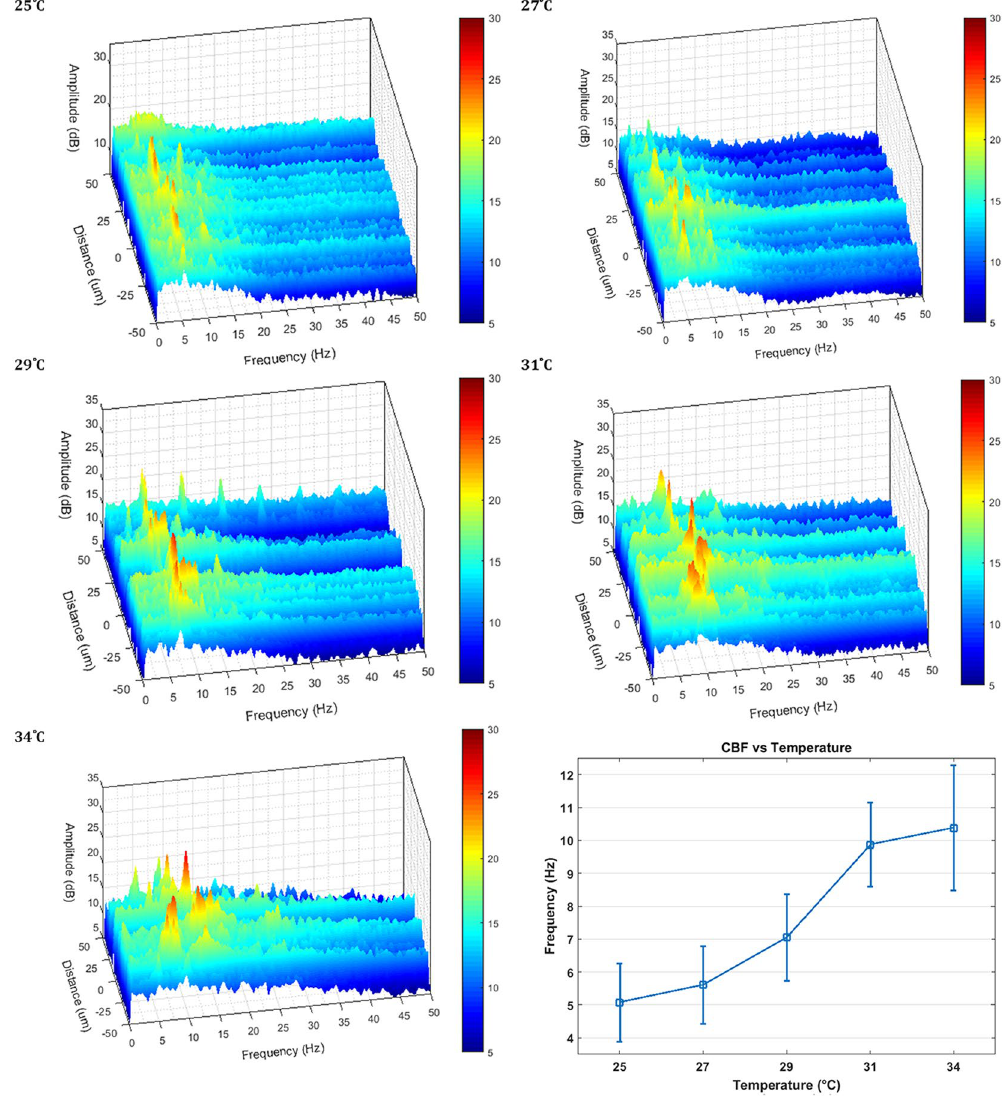
Figure 5. Power spectral density graphs showing peak CBF as a function of space across the sample at temperatures of 25 °C, 27 °C, 29 °C, 31 °C, and 34 °C. Graph of average CBF as a function of